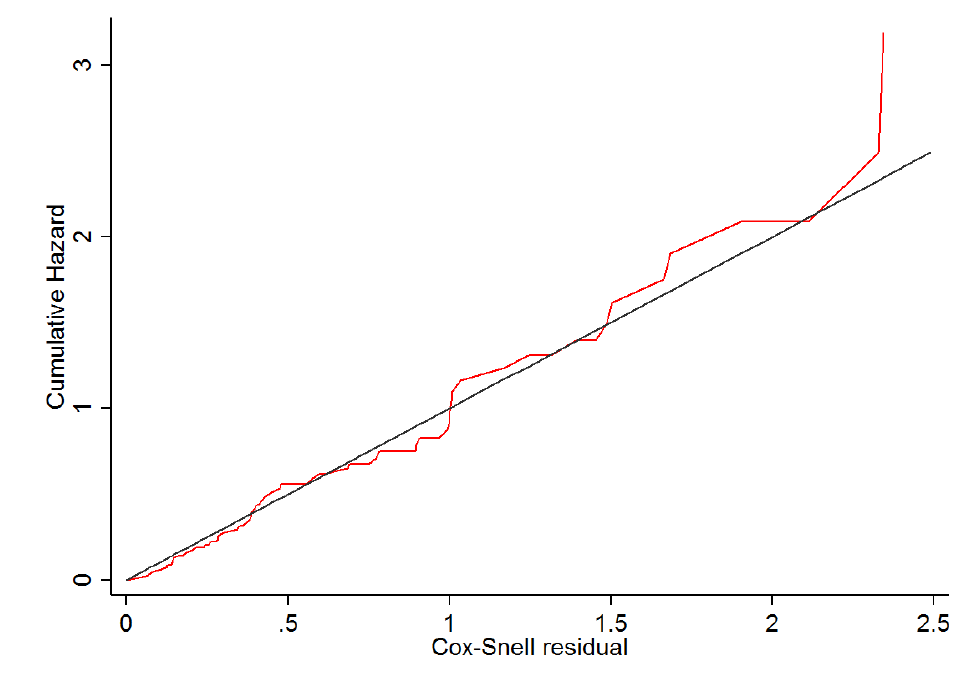
Figure 4. Cox-Snell Residuals Model Fit Assessment. Note: This figure provides the Cox-Snell Residual Model Fit Assessment of the Cox Proportional Hazard Model from Equation